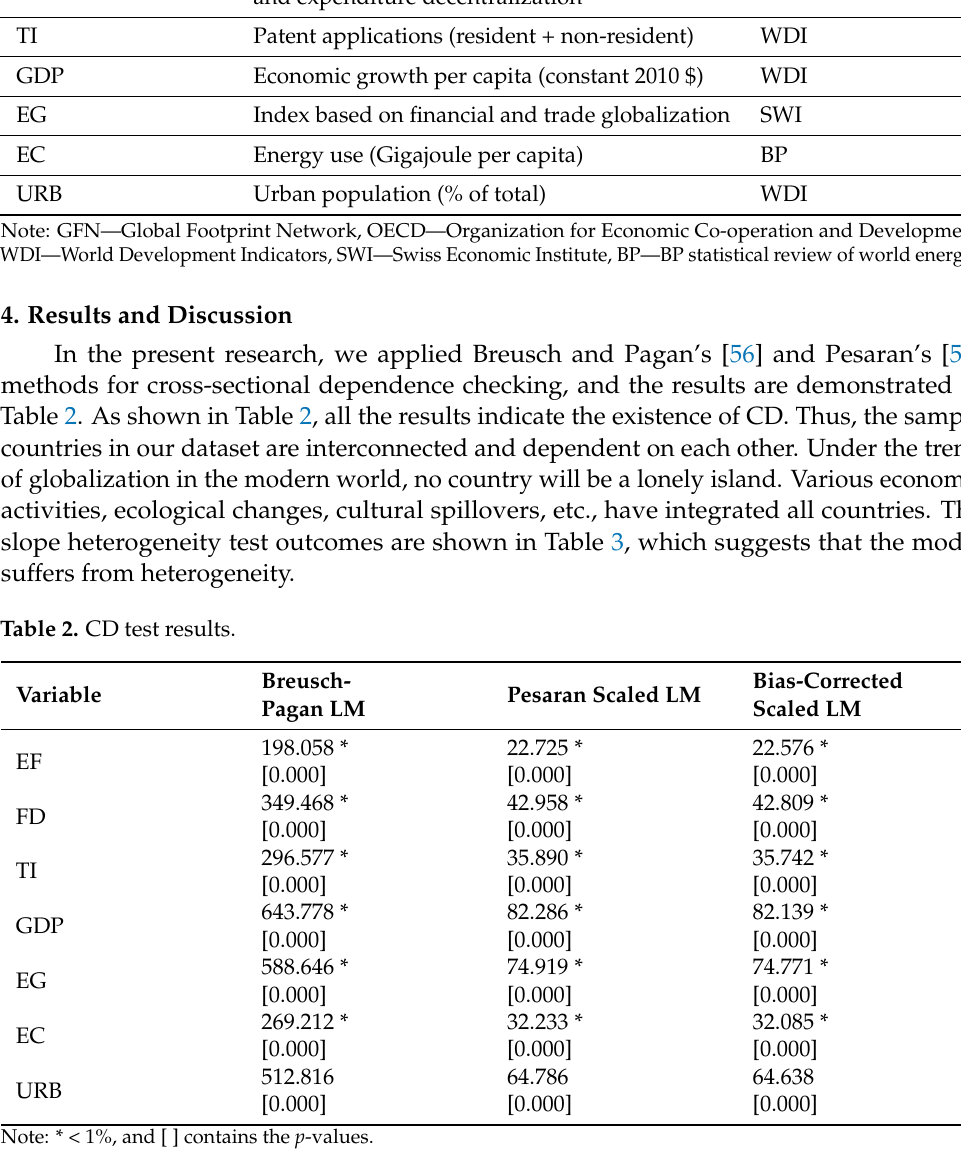
Table 3. Slope heterogeneity test